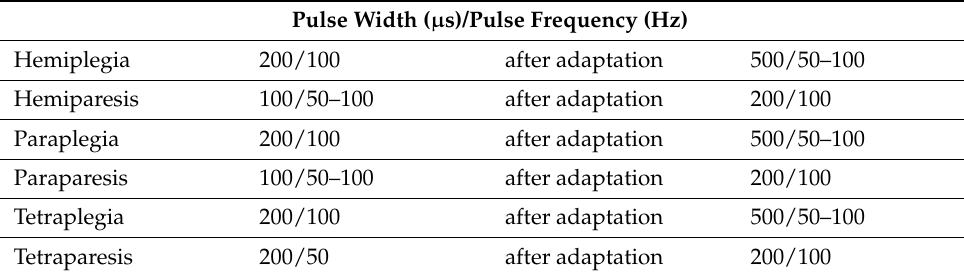
Table 1. FES parameters for hemiplegic patients.